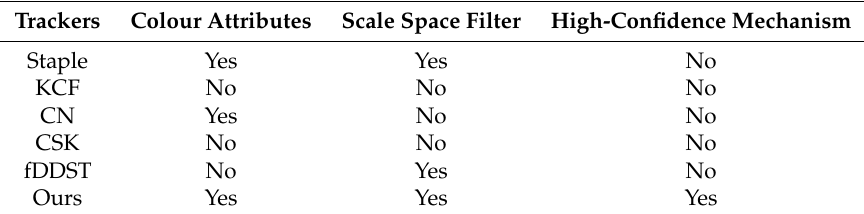
Table 4. The characteristics of 6 trackers based on correlation